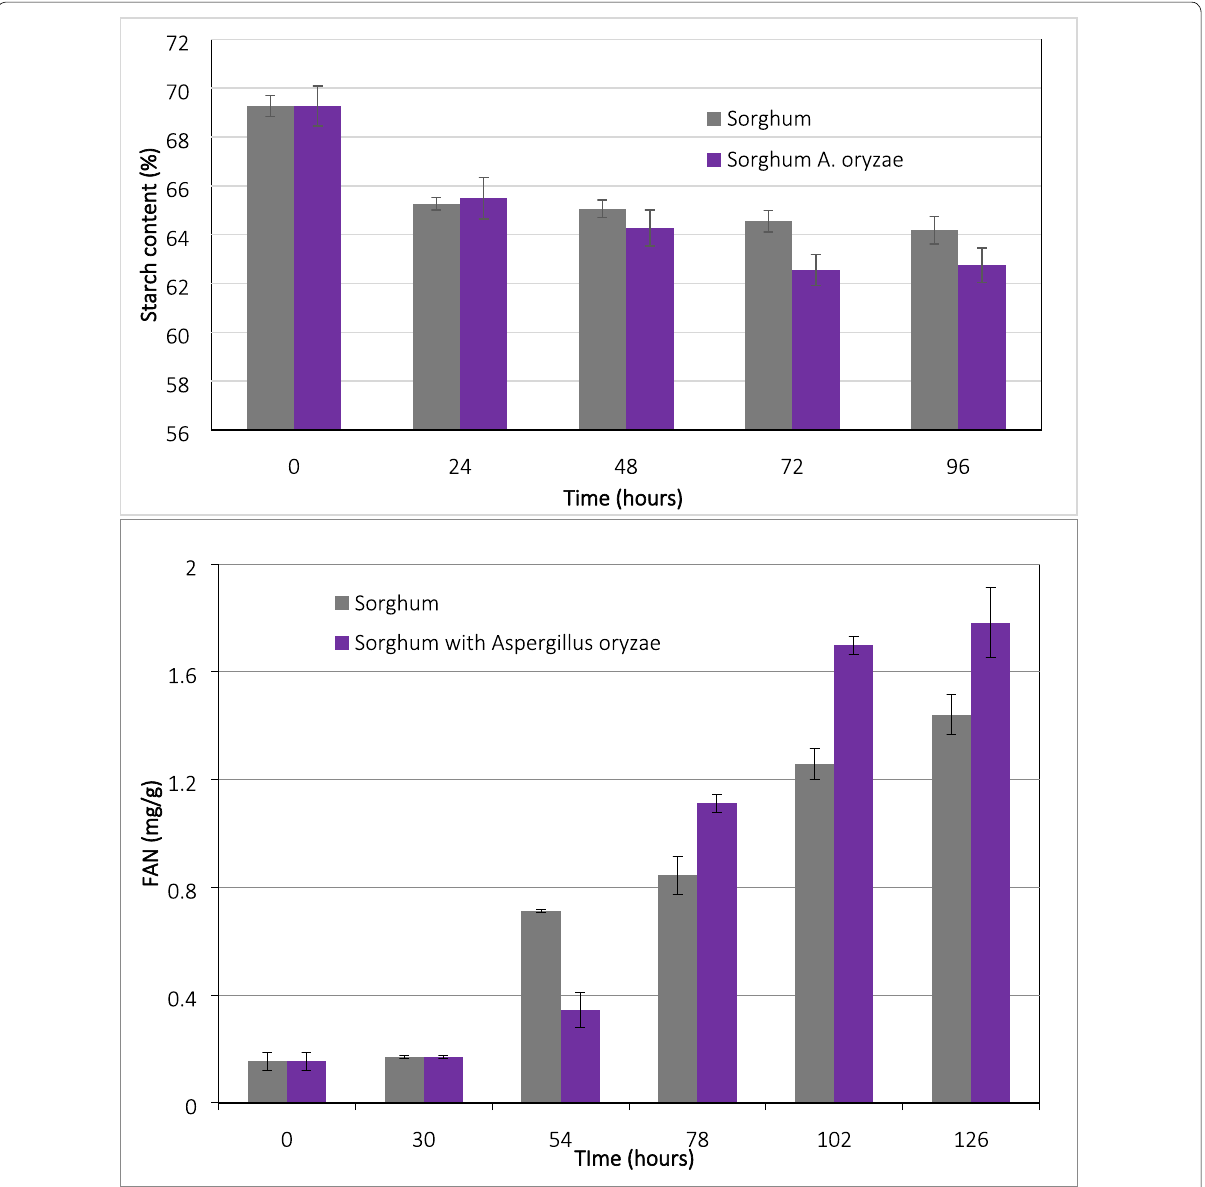
Fig. 1 Changes in starch (dry basis) and Free Amino Nitrogen (mg/g) contents during germination of sorghum with or without A.